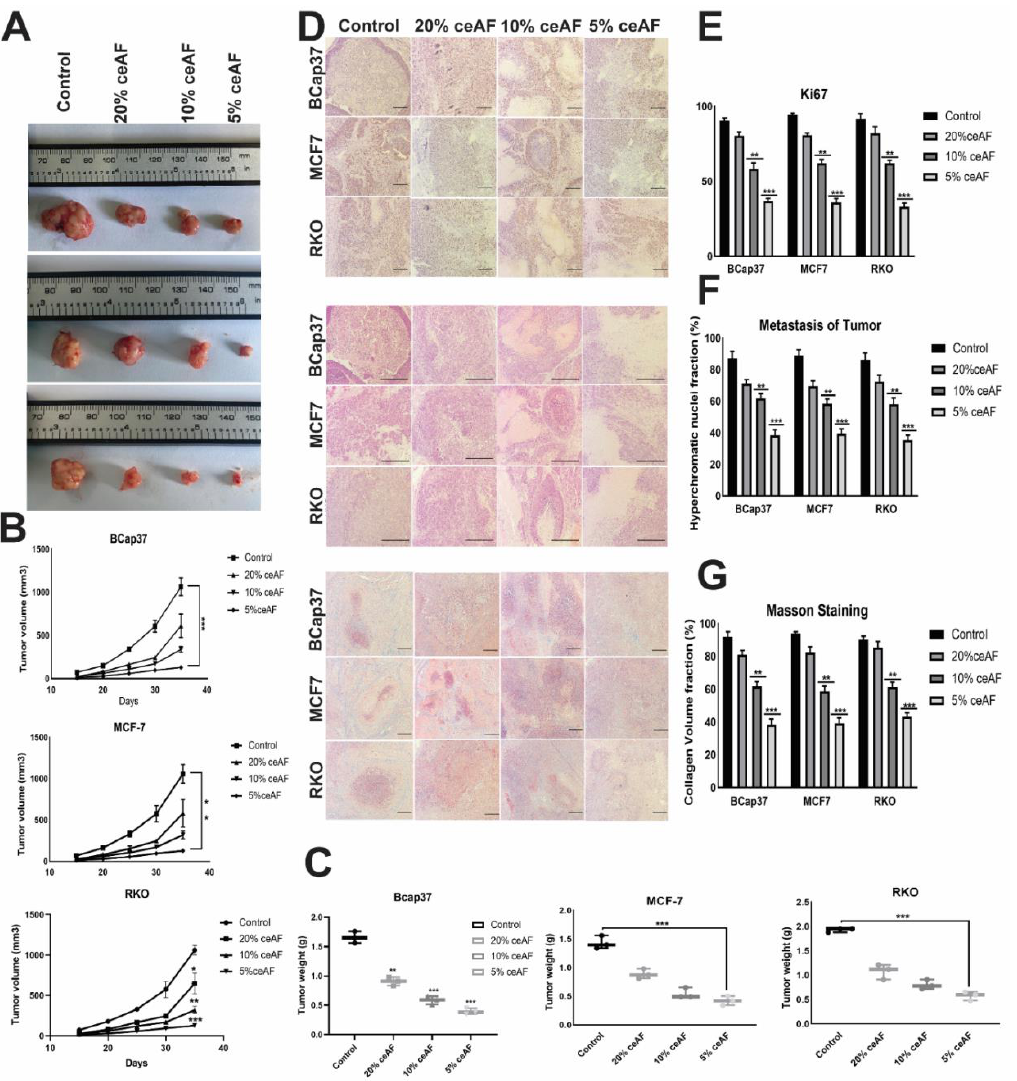
Figure 5. ceAF significantly inhibits tumor metastasis in the xenografts model (in vivo). The effect of ceAF in tumor growth inhibition in nude mice. Tumor size and tumor weight of mice treated with different fractions of ceAF (20, 10, and 5 v / v ) compared to the control group (cells inoculated without giving any treatment) ( A ). Body weight and tumor volume (mean ± SD) of nude mice are shown ( B , C ). Representative staining images of H&E, Ki67, and Masson Trichrome in tumor xenografts ( D ). Significantly large necrotic areas in the 5% ceAF treated group can be seen as indicated via H&E staining. Decreased expression of Ki67 in the tumors treated with 5% ceAF mice can also be seen compared with control ( E ). In vivo inhibition of angiogenesis and increased necrosis with ceAF treatment was observed and validated via Masson’s trichrome staining ( F ). Density of collagen fibers per unit area (percentage) among different groups can be seen in ( G ). A relative quantification of nuclei fraction, number of positive Ki67 stained cells, and collagen volume fraction are shown in the extreme right panel, whereas statistical significance was evaluated with a two-way ANOVA with Bonferroni post-test. (N = 3/group) where,* p < 0.05, ** p , 0.001 and *** p < 0.001. scalebar represents 100 µ